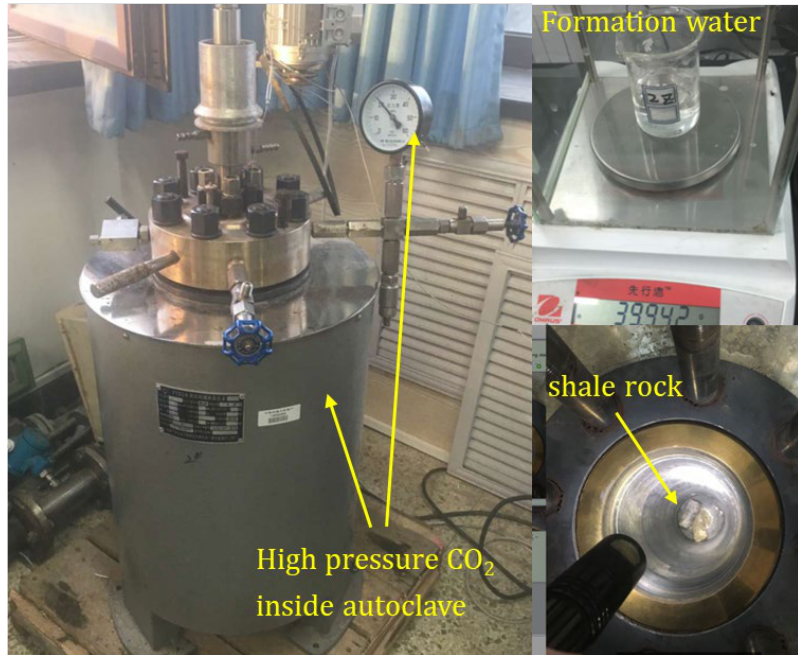
Figure 5. High-temperature and high-pressure autoclave.